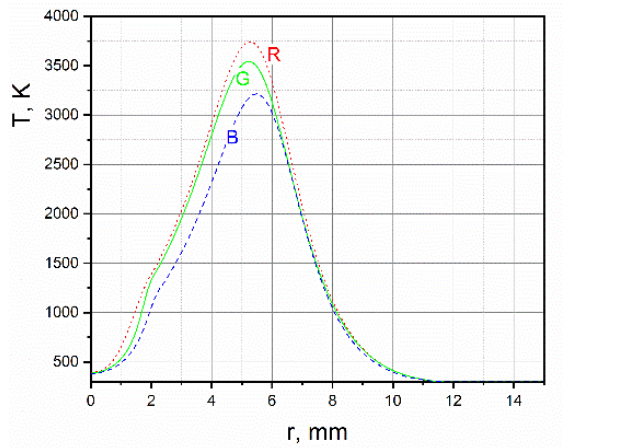
Figure 3. ( a ) Radial distribution of temperature obtained in the air approximation in each RGB- channel of the hilbertogram; ( b ) black curve — equilibrium distribution of temperature; blue curve — temperature obtained by the Tikhonov regularization.